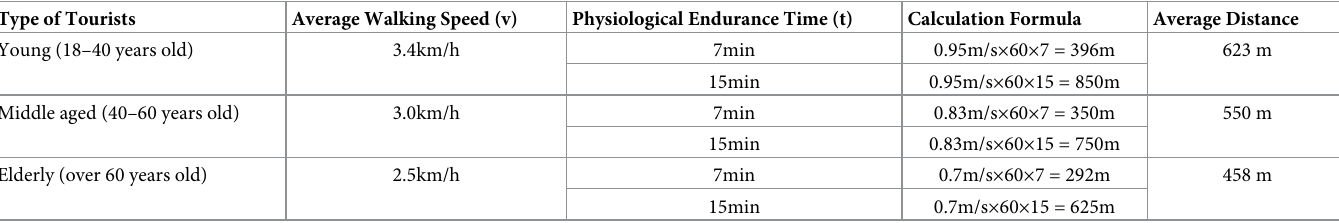
3.2.2 Scenic areas. The reasonable distances between tourist toilets in scenic areas were determined on the basis of the general physiological endurance time, the average walking speed of tourists of different ages, and the standards in relevant documents and literature [24, 45]. The average walking speed were obtained from the average walking speed of 10 randomly selected young, middle-aged and elderly tourists over the same section of a road, while the average distance of tourist toilets required by tourists of different ages relied on the average value calculated from the minimum and the maximum physical endurance time (7–15 min- utes) (Table 2). Considering that China has entered an aging society and the high frequency of urination main reference standard for determining the distance between tourist toilets should be the Table 2. Calculation of distance between tourist